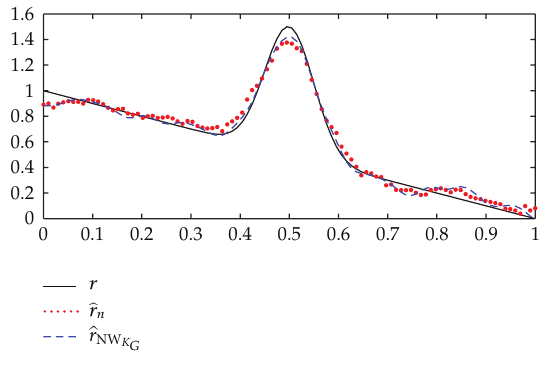
Figure 2: Estimation of r with (cid:2) r n and (cid:2) r